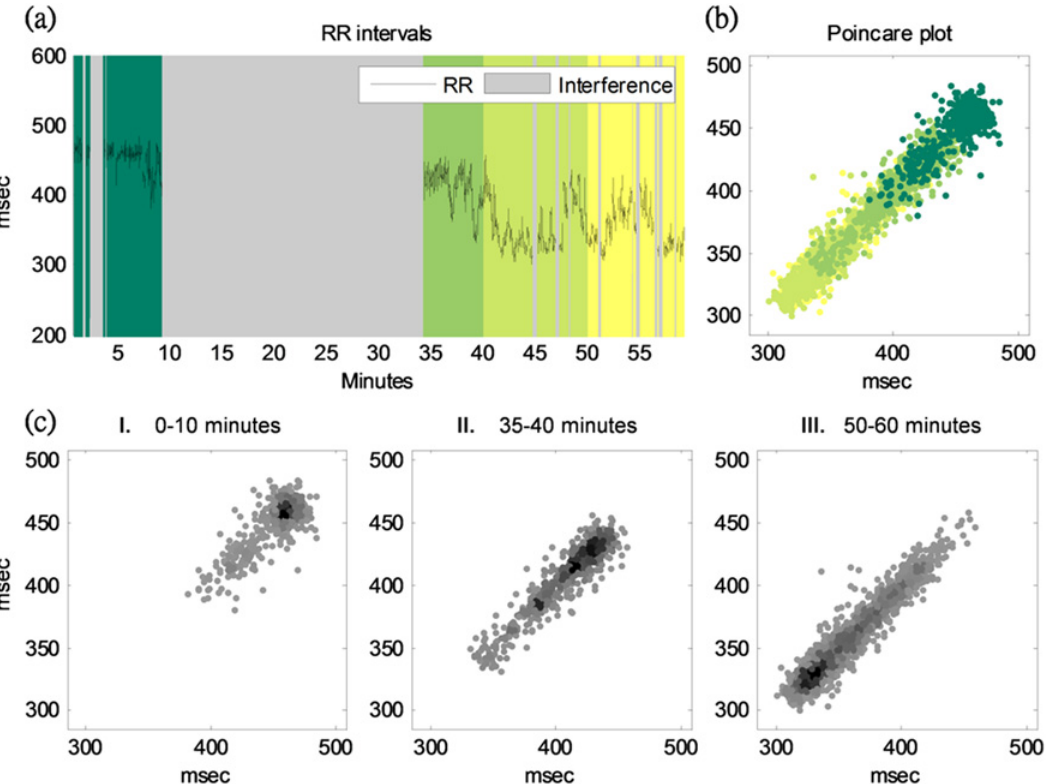
Fig 4. Poincaré plot of the fetal R-R interval time series of a study subject from baseline preparation to the caesarean-section delivery of the fetus. (a) Fetal R-R interval time series of a study subject from baseline preparation to the caesarean-section delivery of the fetus. Three time points-baseline, 5 minutes after anesthesia, and 5 minutes before delivery-were marked by colors of deep green, light green, and yellow. The Poincaré plot for the whole recording is marked with different colors to show the temporal change (b). Detailed Poincaré plot of three stages is provided in Fig. 4c to 4e.